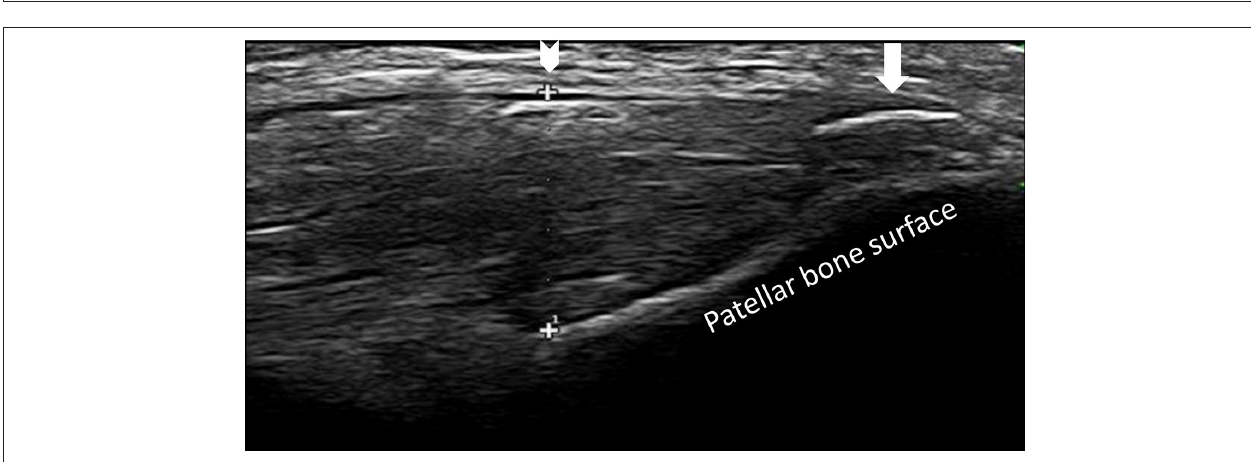
FIGURE 3 | Longitudinal scan of the distal patellar tendon in a patient with gout shows increased thickness, hypoechogenicity (arrowhead), and calcification (arrow).